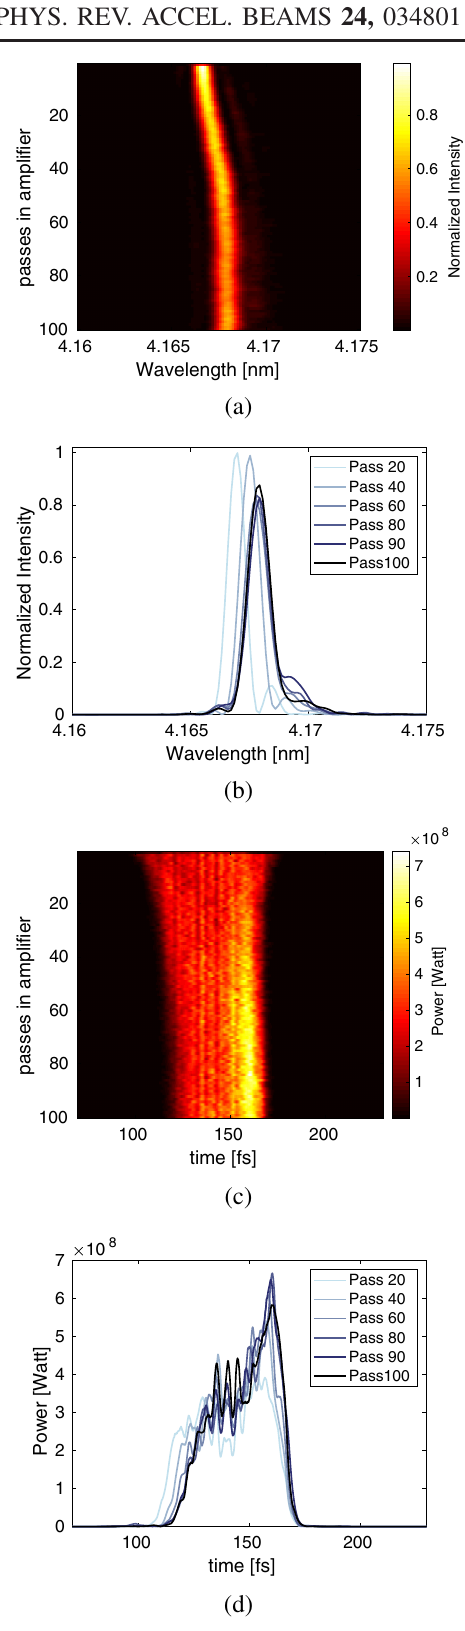
FIG. 4. 5th harmonic of a 300 nm seed light pulse. (a) Output spectrum per pass at amplifier. (b) Output spectrum for selected passes. (c) Power per pass in amplifier along the intrabeam coordinate s . (d) Output power profile for selected